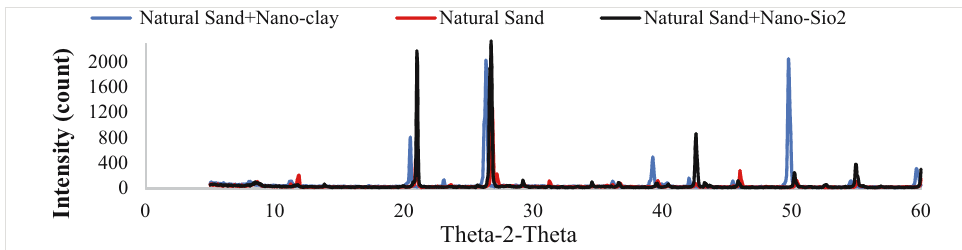
Figure 2: X - ray analysis of sand treated with nano - clay and nano - SiO 2 .